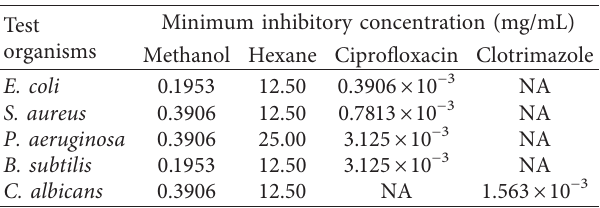
NA: not applicable. Table 8: Separated constituents of V. camporum extracts as de- termined using TLC.